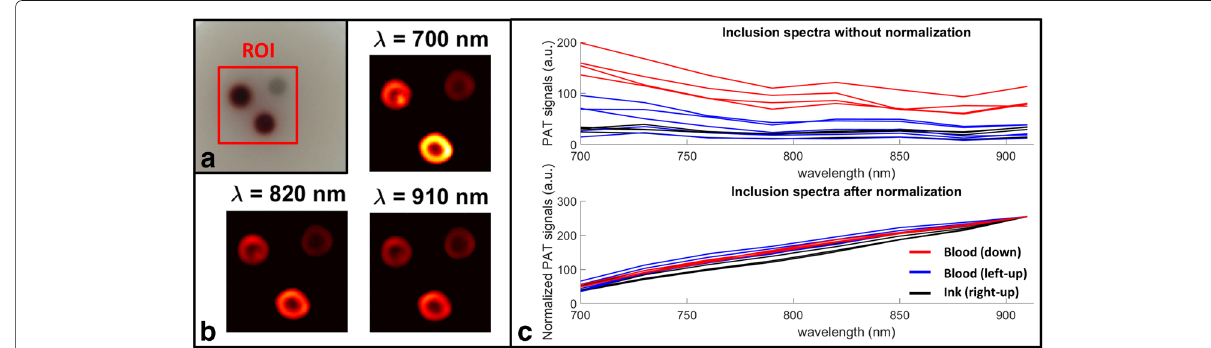
Fig. 5 Photoacoustic tomography acquisition for the blood and ink phantoms. a Phantom used for the discrimination study between blood dilutions. The inclusion in gray is China ink, and the two black inclusions are blood at two different dilutions. b Three photoacoustic experimental ROI images after thresholding at different wavelengths. c Spectral profiles of the selected pixels from each inclusion with (upper) and without (lower)